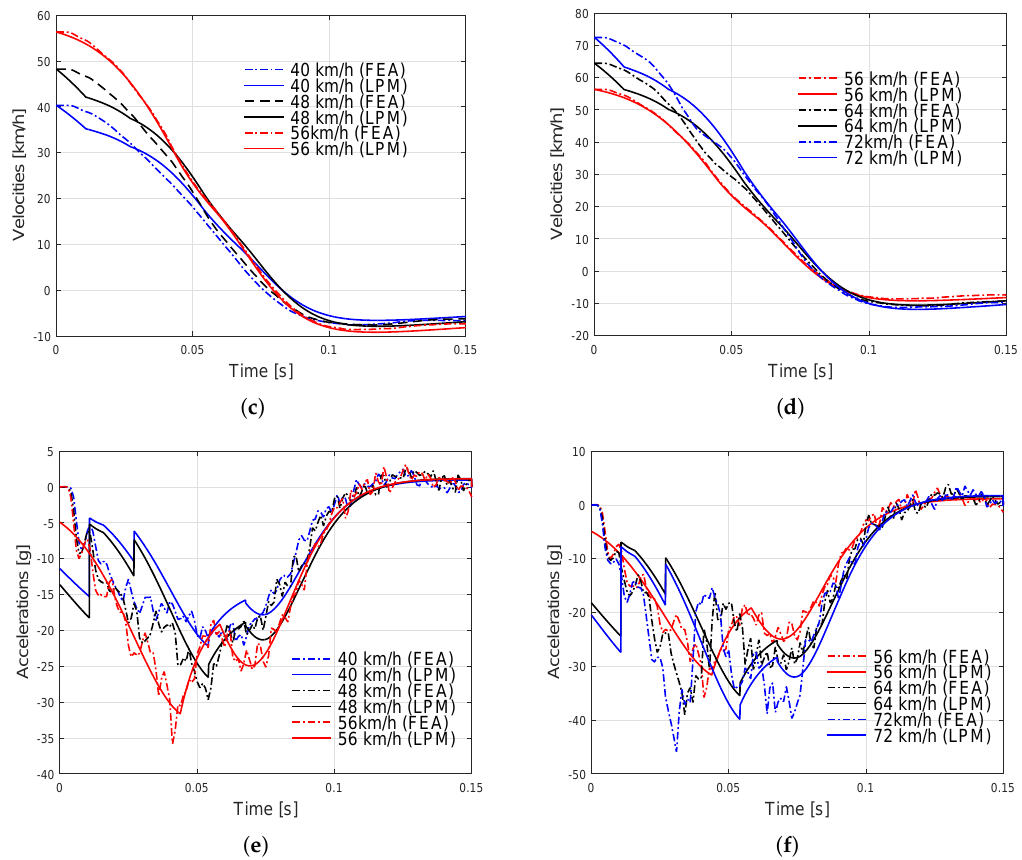
Figure 8. Displacement, velocity, and acceleration plots comparison in case of LPM calibrated to FEA, ( a , c , e ) impact velocities lower than the calibration point (56 km/h); ( b , d , f ) impact velocities higher than the calibration point.